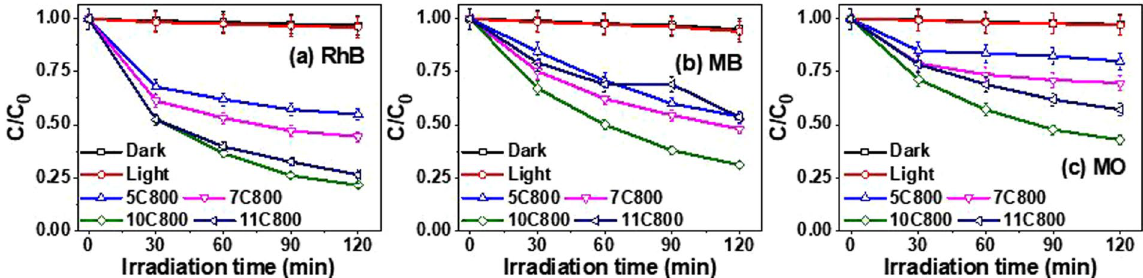
Figure 10. Change in concentration of ( a ) RhB dye, ( b ) MB dye and ( c ) MO dye.